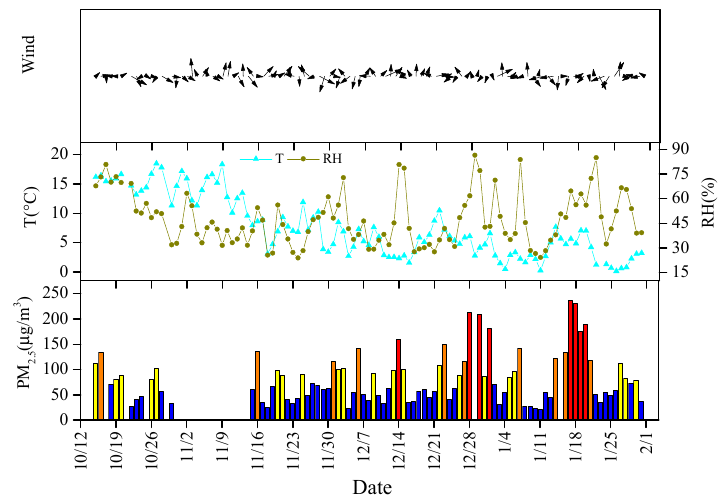
Figure 2. Time series of daily PM 2.5 and meteorological date (blue column represents good days, yellow column represents light days, orange column represents moderate days, red column represents heavy days).